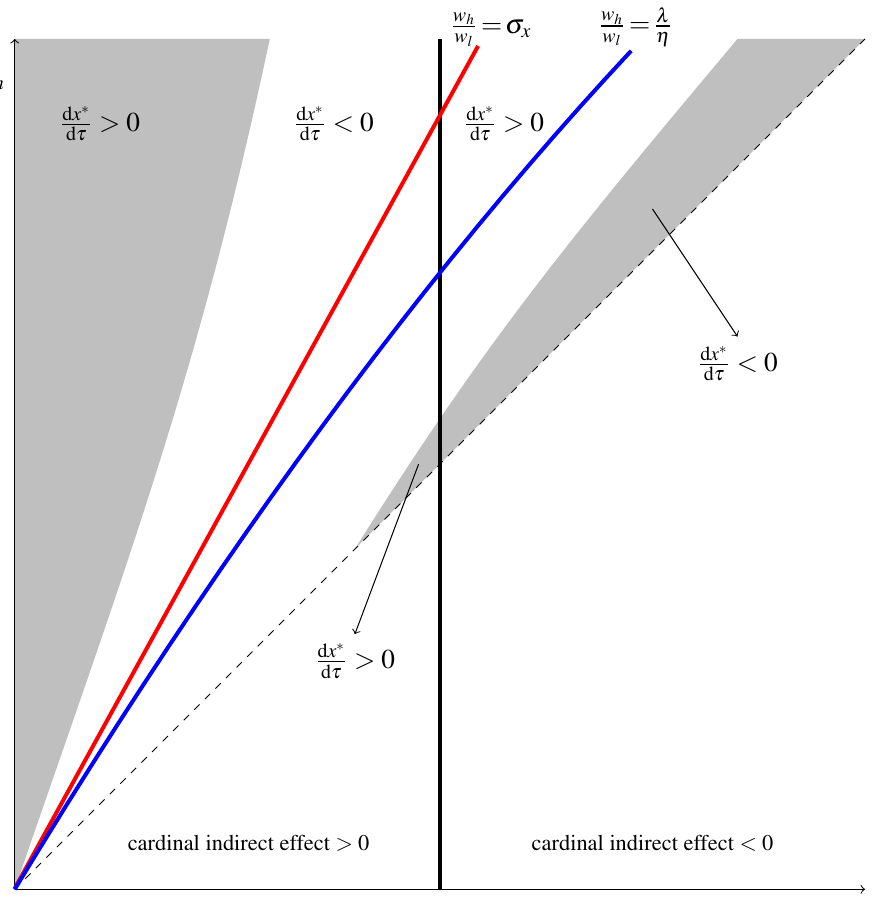
Figure 3: A case where the cardinal status direct effect is negative only for w h / w l > λ / η , as implied by Result 4. The ordinal status effect is positive and when w h / w l > σ x > λ / η , so when σ x > w h / w l > λ / η the sum of the cardinal status direct effect and the ordinal status effect is negative. For a sufficiently high value of w h / w l the positive ordinal status effect dominates (the shaded area on the left). For sufficiently low values of w h / w l the positive cardinal status direct effect dominates, although this can happen only if w l is not too small (the shaded area on the right). The sign of d x ∗ / d τ is obtained taking also into account the sign of cardinal status indirect